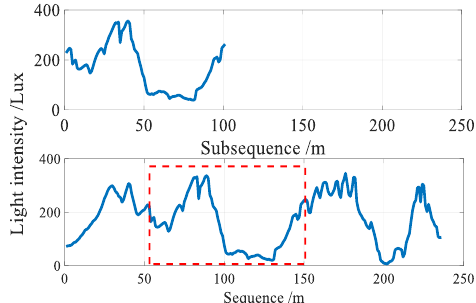
Figure 16. Long trajectory matching via Subsequence DTW.